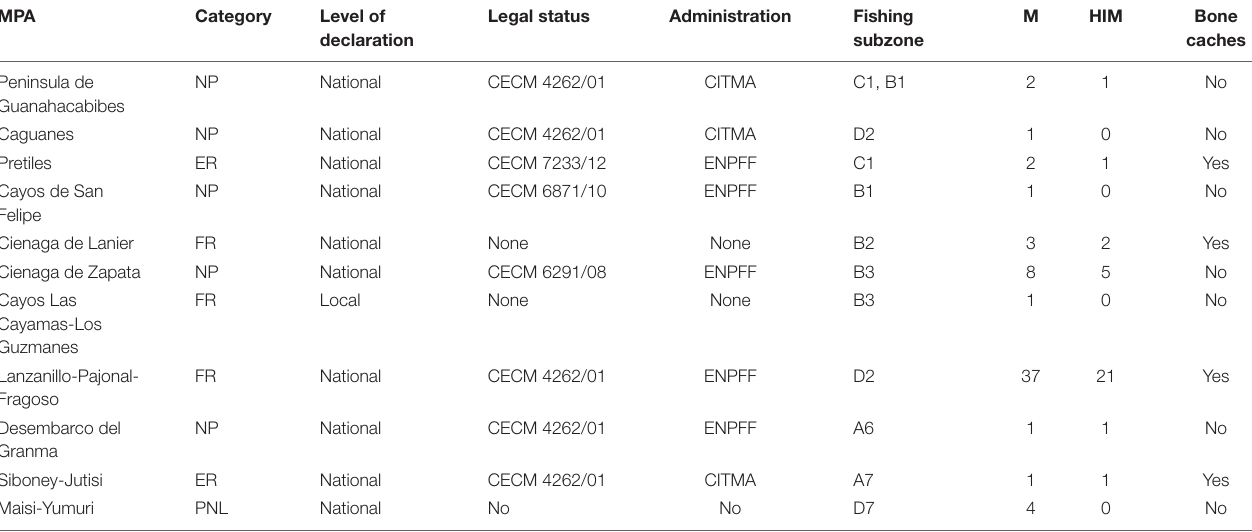
TABLE 3 | Information about marine protected areas (MPAs) in Cuba and events involving manatees until 2018.